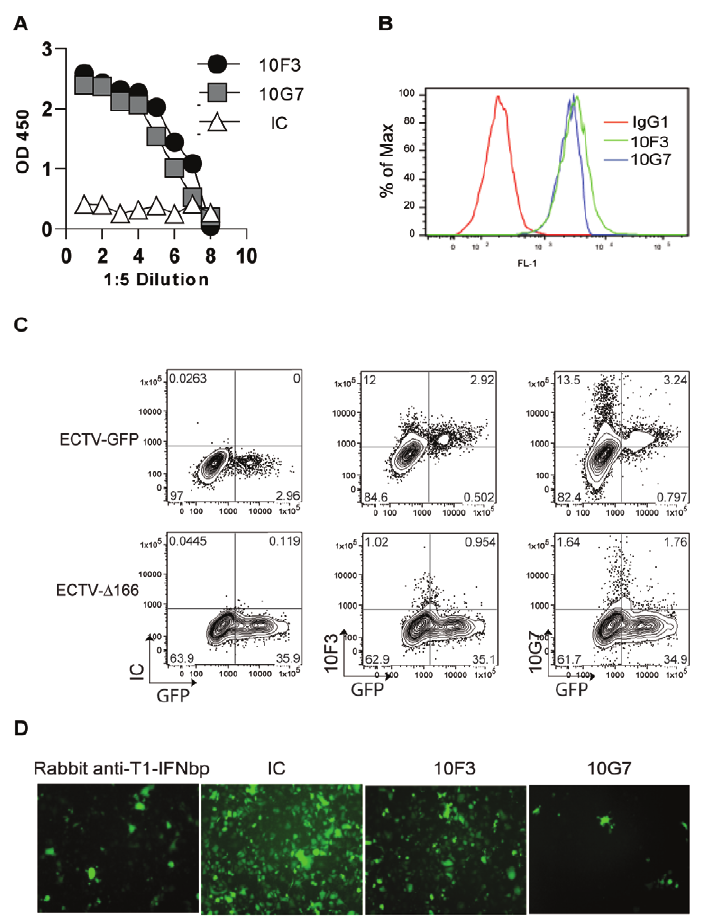
Figure 5. Identification of a mAb that inhibits the biological activity of ECTV T1-IFNbp. A ) ELISA plates were covered with recombinant T1-IFNbp and the presence of the protein was detected with the indicated mAbs or isotype control (IC). Data are representatives of 2 independent experiments with similar results. B ) L929 cells (10 5 ) were incubated with 10 ng recombinant T1-IFNbp at 37 u C for 1 h, thoroughly washed, and the binding of mAb 10G7 (blue line) or 10F3 (green) to the cell surface was analyzed by flow cytometry. C ) L929 cells were infected with ECTV-GFP (upper panels) or ECTV- D 166-GFP (lower panels) at MOI of 0.05 for 16 h. GFP expression and the binding of IC, 10G7 or 10F3 mAbs were determined by flow cytometry as indicated. D ) 10 ng of recombinant ECTV T1-IFNbp was incubated with 10 m l rabbit anti-IFNbp or 10 ng of indicated mAbs for 30 min at 37 u C, incubated with 1U mIFN- a for another 30 min at 37 u C. The cocktail was then added to L929 cells in 96-well plates. The cells were incubated with this cocktail for 24 h, infected with VSV-eGFP at MOI of 0.1 for 16 h and observed for GFP fluorescence under the